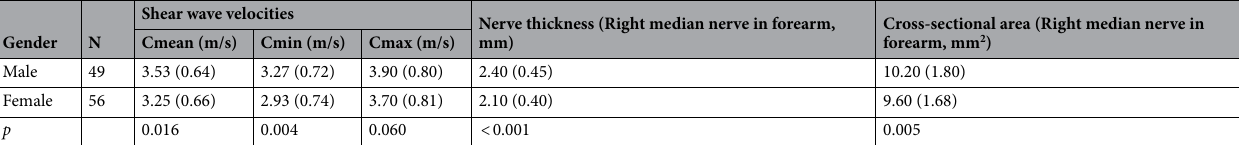
Table 5. Comparison of shear wave velocities of right median nerve at forearm, nerve thickness and cross- sectional area in different genders.